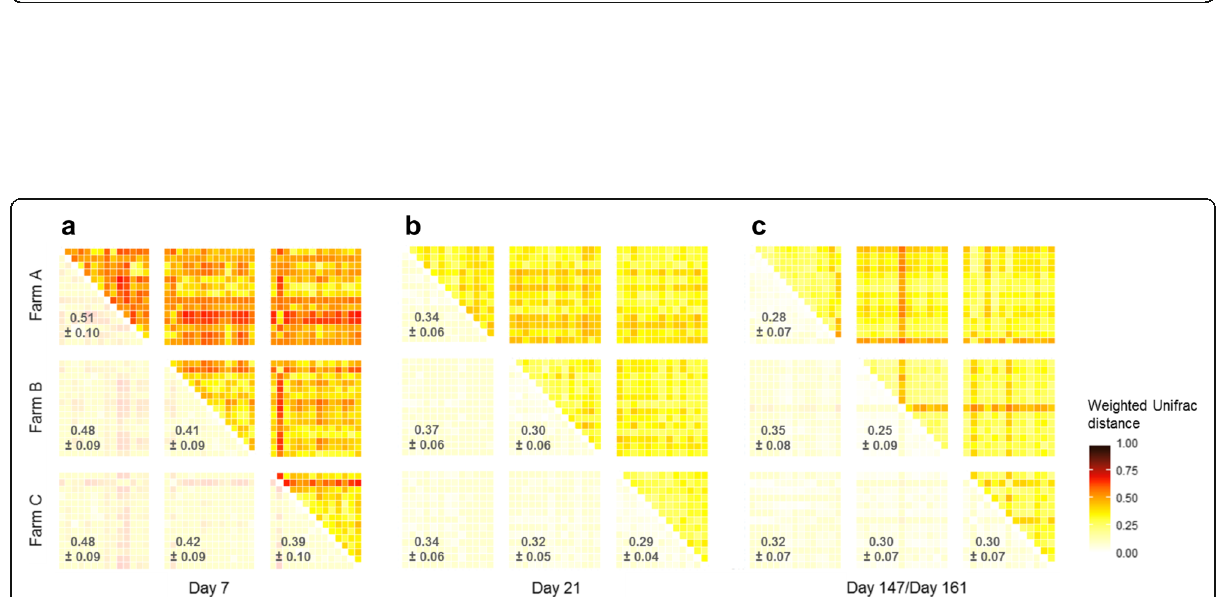
Fig. 1 Scheme of sampling dates for each farm. Sampling points for farm A, farm B, and farm C are represented in the upper panel, middle panel, and lower panel, respectively. “ N ” indicates the number of calves studied on each farm. The days of sampling are indicated by grey dots. Of note, one calf on farm C died during the fattening period and was excluded from the study. Antibiotic treatments are indicated by bold dark lines or back triangles, and the names of the antibiotics are given in the legend